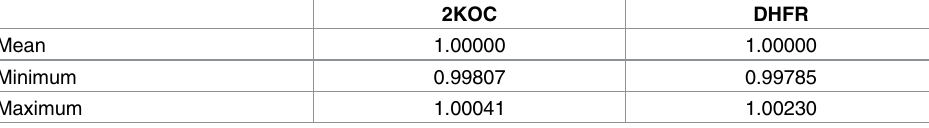
Table 9. Comparison of forces as computed by Gromacs and OpenMM.